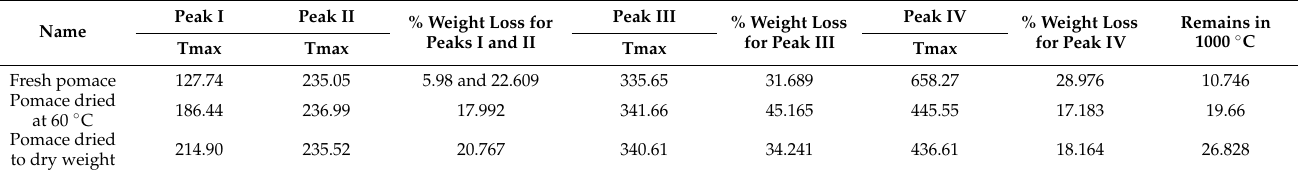
Figure 3. TGA curve for fresh apple pomace. Analysis in a nitrogen atmosphere (black line is a plot of mass loss versus temperature, red line is the first derivative). Table 2. Percent weight loss and peak maximum temperature ( ◦ C) for apple-pomace samples based on the obtained TGA curves. Analysis under nitrogen atmosphere.